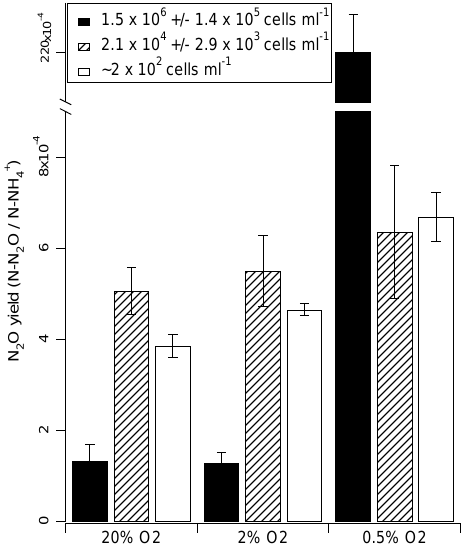
Fig. 2. N 2 O yields vs. cell density. Each bar represents the average of 5 replicate cultures. Error bars are for one standard deviation among replicates.